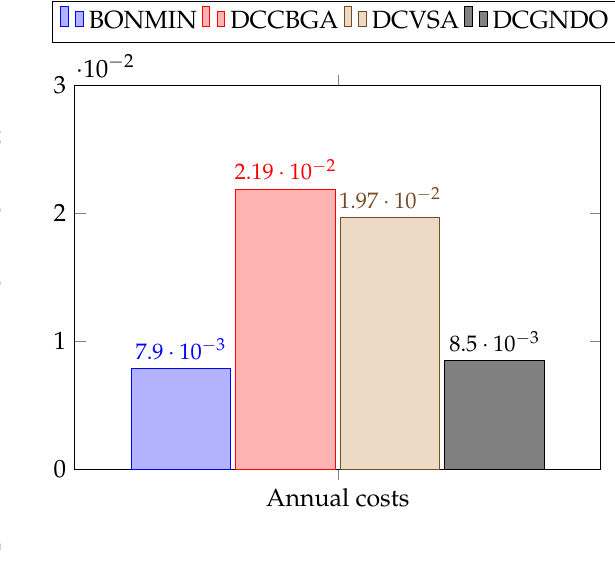
Figure 6. Improvements in the reduction of annual costs as achieved by DCPPSO with respect to the comparison methods in the 69-bus test system.